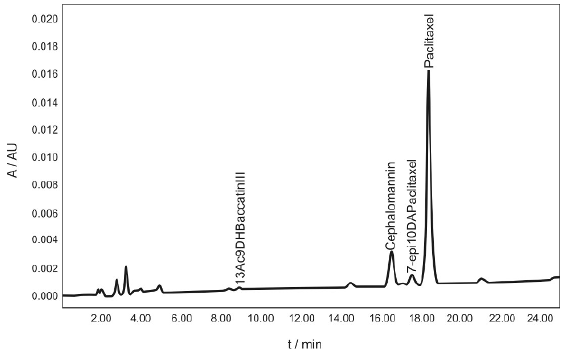
Figure 3. Chromatogram of crude plant